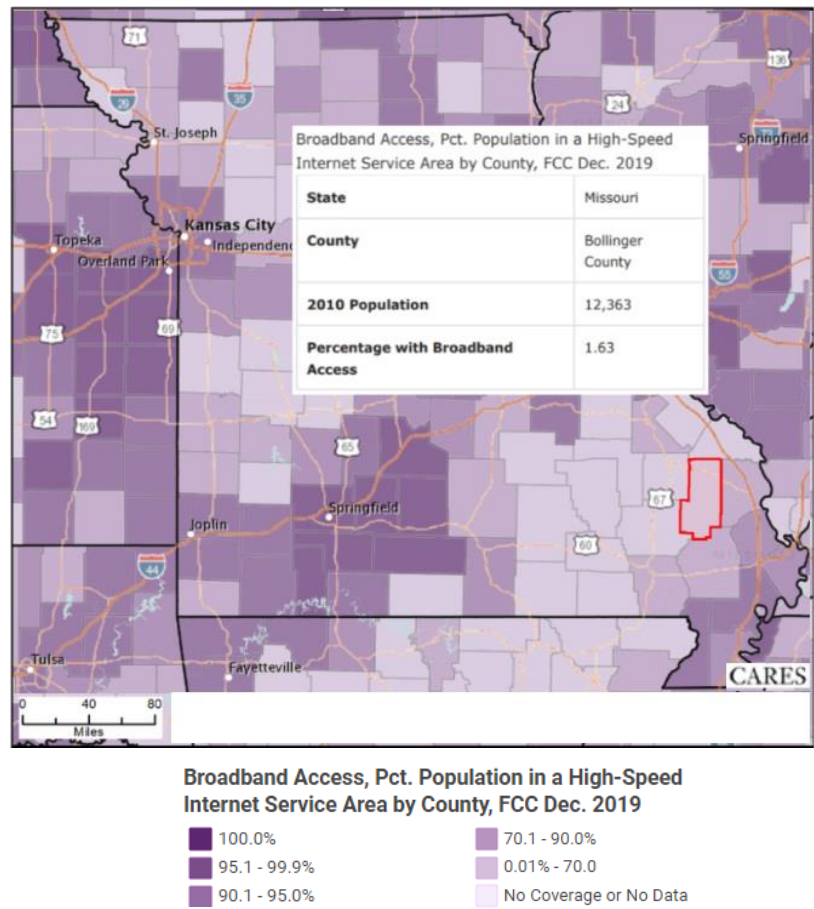
Figure 2. Missouri Broadband Access